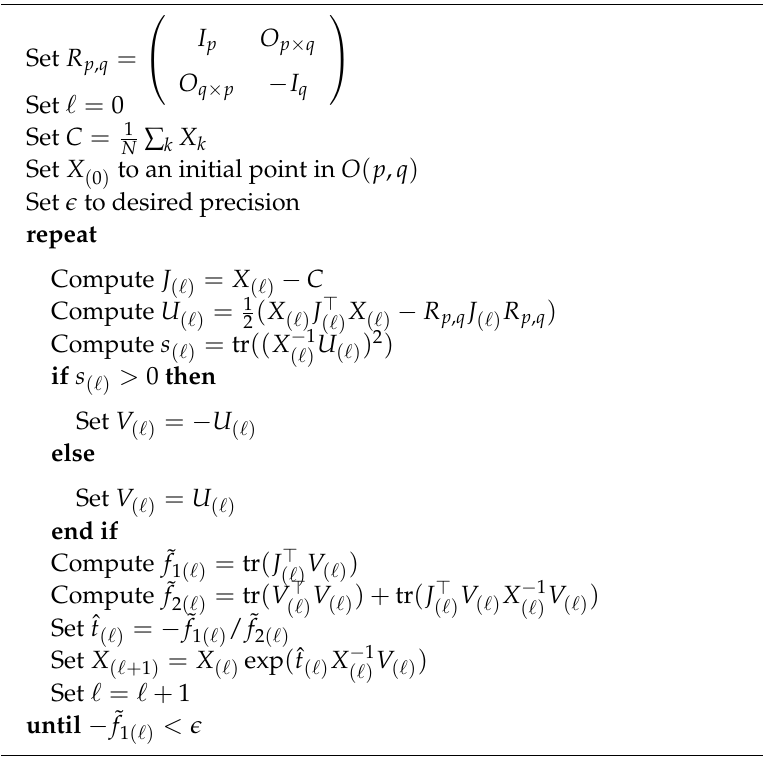
Algorithm 1 Pseudocode to implement mean-computation over O ( p , q ) according to the function minimization rule (7) endowed with the step-size-selection rule in Equation (11) and the stopping criterion in Equation